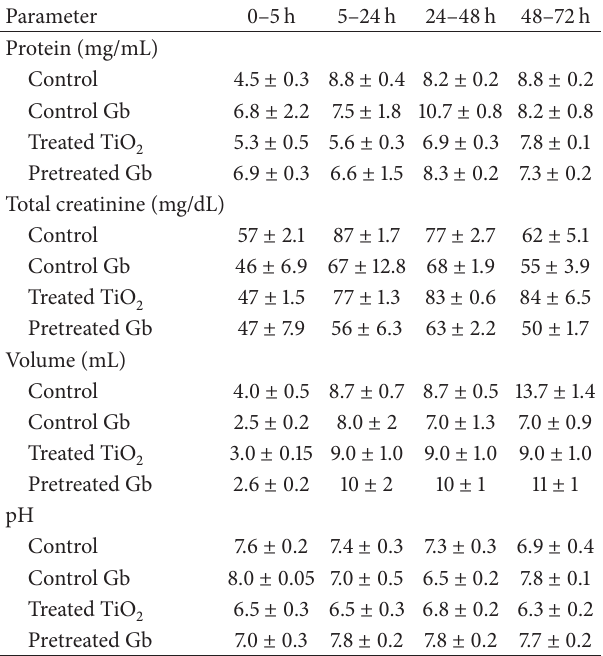
Values represent mean ± SEM ( 𝑛 = 6 ). Table 2: The effects of the Ginkgo biloba extract (10mg/kgb.w., intraperitoneal) administered 24 h before titanium dioxide (5mg/kg b.w., intravenous) on general parameters studied.